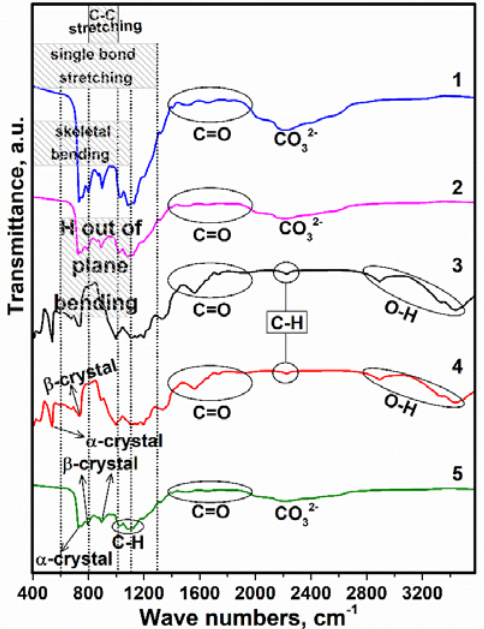
Figure 5. FTIR spectrum of deposited thin